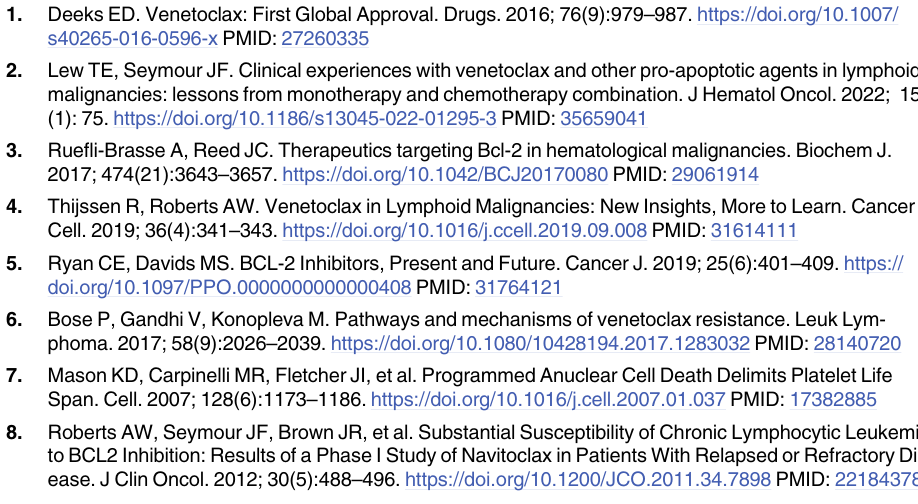
S1 Table. Four major algorithms used for signal detection. S2 Table. Signal strength of all AEs reports associated with venetoclax at the PT